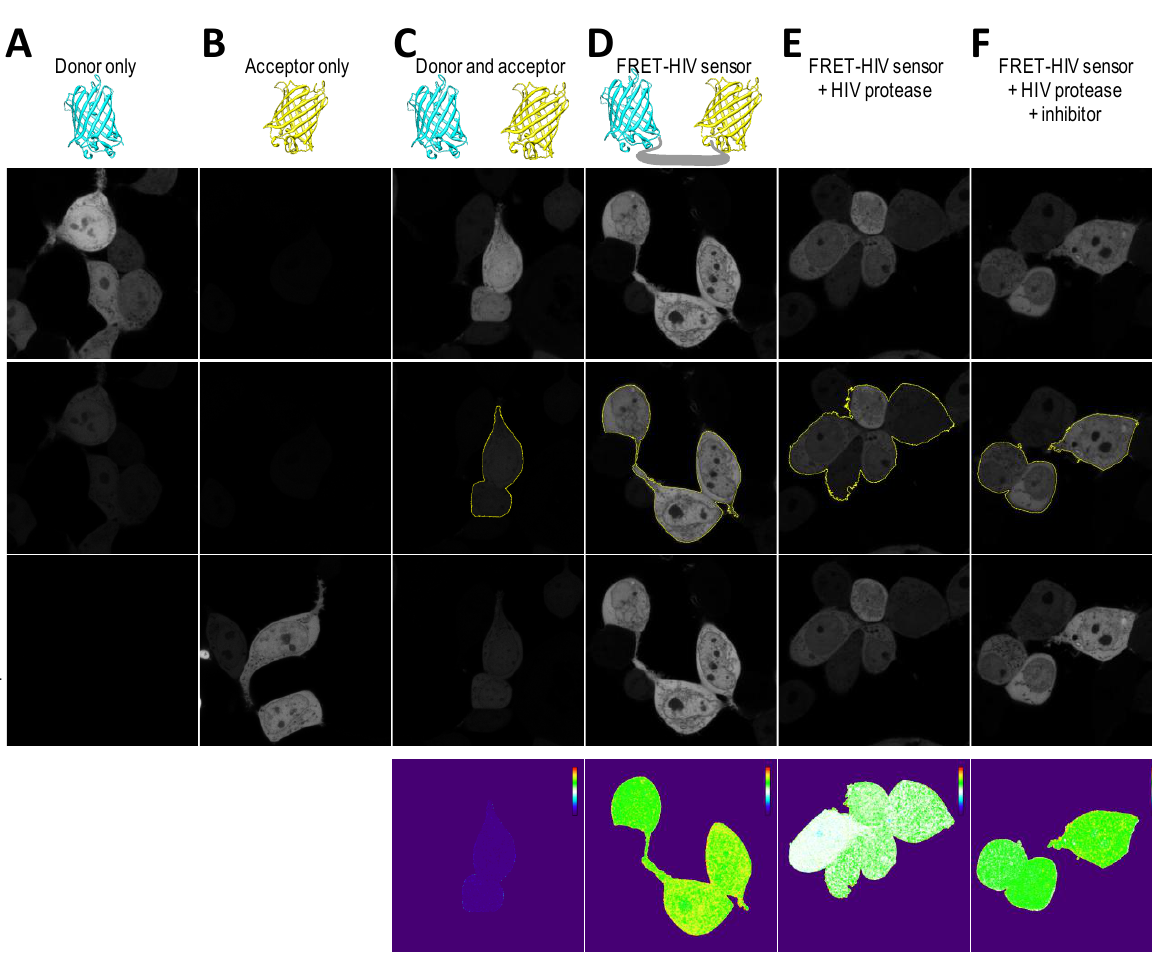
Figure 5. Sensitized emission FRET analysis was used for imaging the spatial expression of the HIV protease in live cells with the FRET-HIV sensor. Images of cells expressing ( A ) mCerulean alone, ( B ) mCitrine alone, or ( C ) mCerulean and mCitrine together, ( D ) and the FRET-HIV protease sensor without or ( E and F ) with the transgene HIV protease are shown. Images were taken in the donor [ex. 405, em. 465 to 495 nm], acceptor (ex. 514 nm, em. 535 to 555 nm), and FRET (ex. 405 nm, em. 535 to 555 nm) settings. For the indicated cells, linNFRET images were generated by pixel-by-pixel calculation using the PixFret plug-in (ImageJ) and were pseudo-colorized (violet stands for 0 and red stands for 0.4). Depicted microscopy images are representative results from three independent